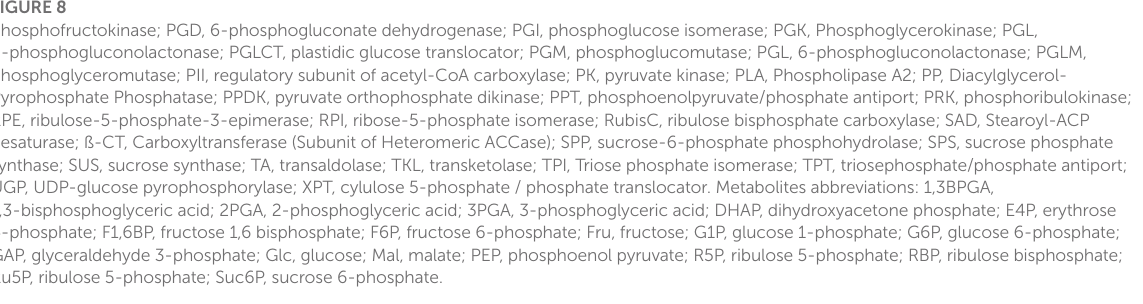
FIGURE 8 phosphofructokinase; PGD, 6-phosphogluconate dehydrogenase; PGI, phosphoglucose isomerase; PGK, Phosphoglycerokinase; PGL, 6-phosphogluconolactonase; PGLCT, plastidic glucose translocator; PGM, phosphoglucomutase; PGL, 6-phosphogluconolactonase; PGLM, phosphoglyceromutase; PII, regulatory subunit of acetyl-CoA carboxylase; PK, pyruvate kinase; PLA, Phospholipase A2; PP, Diacylglycerol- Pyrophosphate Phosphatase; PPDK, pyruvate orthophosphate dikinase; PPT, phosphoenolpyruvate/phosphate antiport; PRK, phosphoribulokinase; RPE, ribulose-5-phosphate-3-epimerase; RPI, ribose-5-phosphate isomerase; RubisC, ribulose bisphosphate carboxylase; SAD, Stearoyl-ACP desaturase; ß-CT, Carboxyltransferase (Subunit of Heteromeric ACCase); SPP, sucrose-6-phosphate phosphohydrolase; SPS, sucrose phosphate synthase; SUS, sucrose synthase; TA, transaldolase; TKL, transketolase; TPI, Triose phosphate isomerase; TPT, triosephosphate/phosphate antiport; UGP, UDP-glucose pyrophosphorylase; XPT, cylulose 5-phosphate / phosphate translocator. Metabolites abbreviations: 1,3BPGA, 1,3-bisphosphoglyceric acid; 2PGA, 2-phosphoglyceric acid; 3PGA, 3-phosphoglyceric acid; DHAP, dihydroxyacetone phosphate; E4P, erythrose 4-phosphate; F1,6BP, fructose 1,6 bisphosphate; F6P, fructose 6-phosphate; Fru, fructose; G1P, glucose 1-phosphate; G6P, glucose 6-phosphate; GAP, glyceraldehyde 3-phosphate; Glc, glucose; Mal, malate; PEP, phosphoenol pyruvate; R5P, ribulose 5-phosphate; RBP, ribulose bisphosphate; Ru5P, ribulose 5-phosphate; Suc6P, sucrose